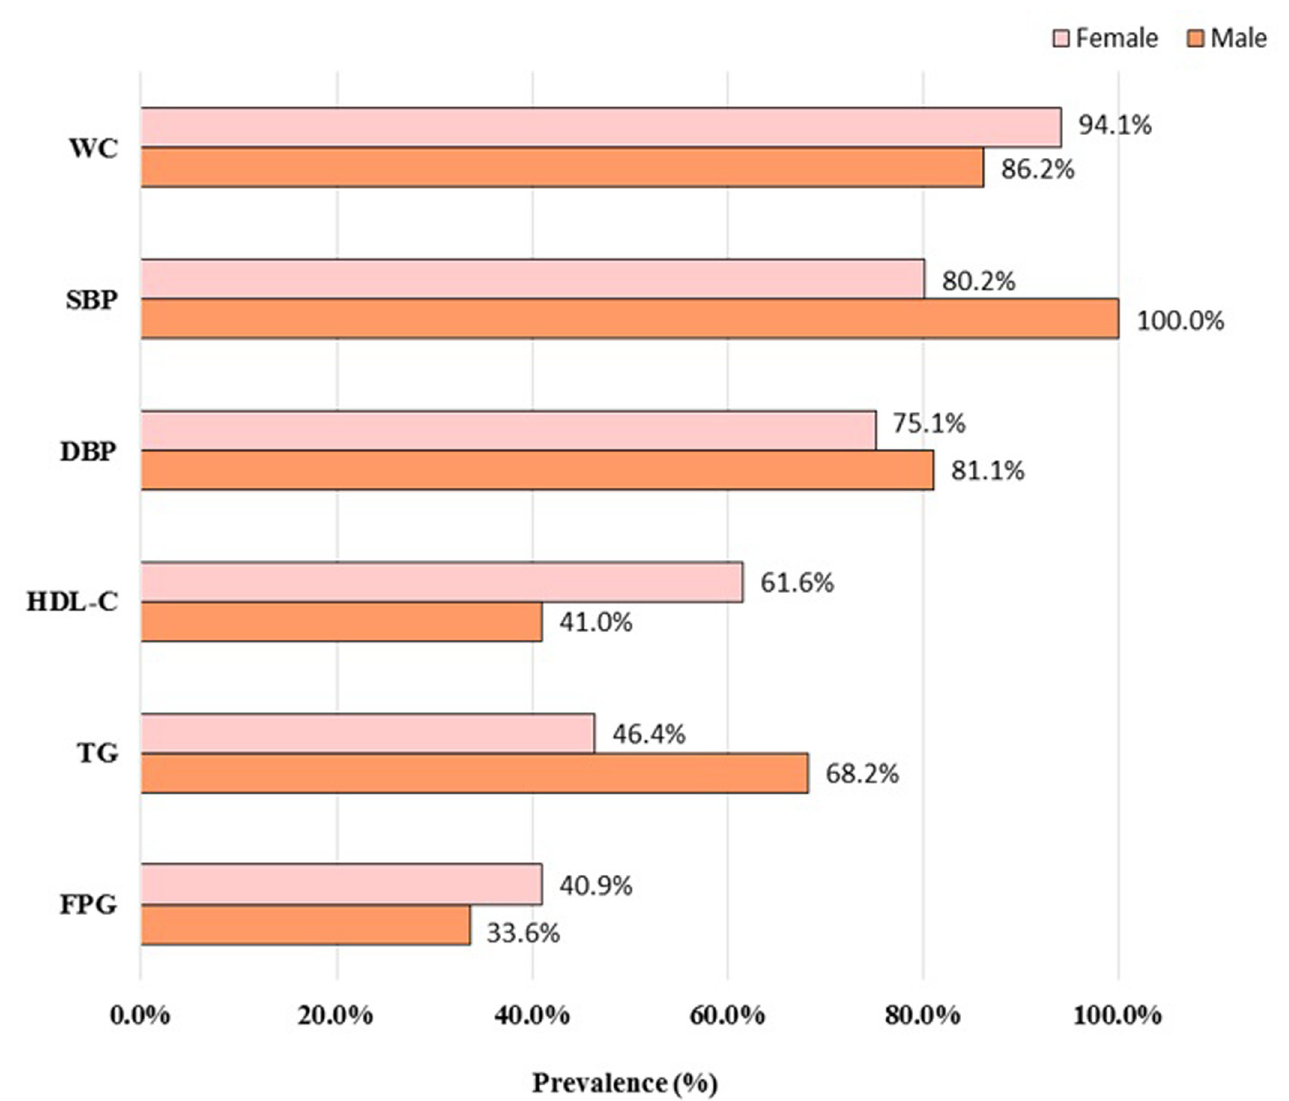
Fig 1. Total number of Kazakh patients with each MS components (IDF diagnostic criteria). Note: WC, waist circumference; SBP, systolic blood pressure; DBP, diastolic blood pressure; HDL-C, high density lipoprotein cholesterol; TG, triglyceride; FPG, fasting plasma glucose.